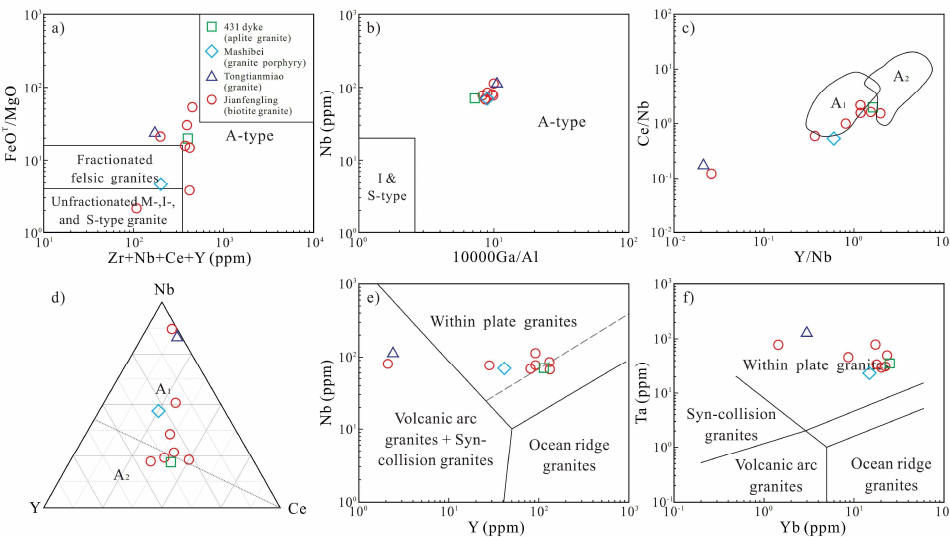
Figure 14. Discrimination diagram of granite genetic type and tectonic setting in the Xianghualing ore field. ( a ) Zr+Nb+Ce+Y vs. FeO T /MgO [45]; ( b ) 10,000 Ga/Al vs. Nb [45]; ( c ) Y/Nb vs. Ce/Nb [48]; ( d ) Nb vs. Y vs. Ce [48]; ( e ) Y vs. Nb [47]; ( f ) Yb vs. Ta [47].